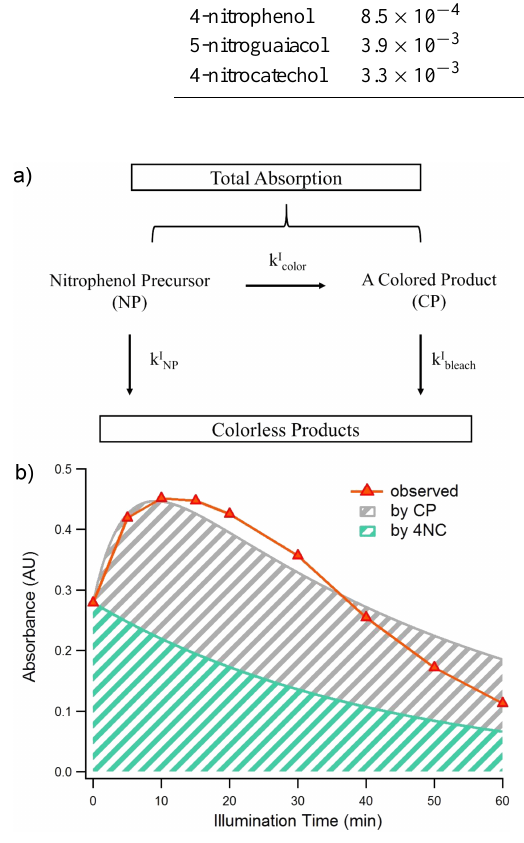
Figure 9. A schematic illustration of the simple kinetic model (a) and one example of 4NC photooxidation (b) . The shaded areas in (b) are the contributions from a newly formed colored product (CP) and the decaying 4NC, respectively. The red line follows data from an